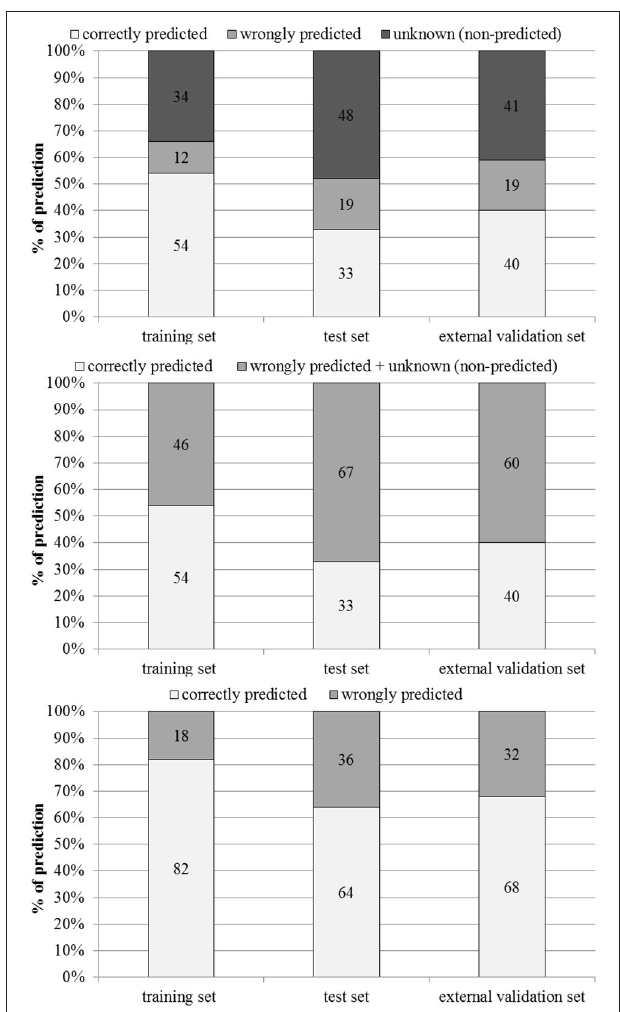
FIGURE 3 | Percentages of correctly predicted, wrongly predicted and non-predicted (unknown) compounds in the training, test and external validation